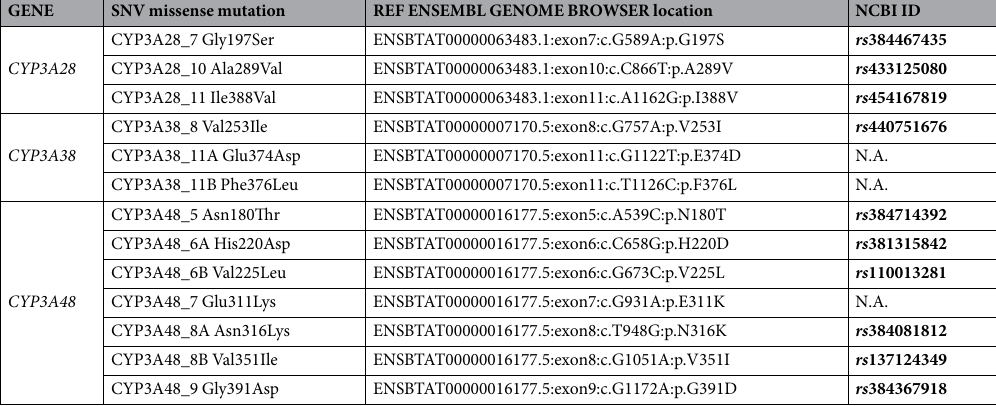
Chi-square test ** p-value < 0.01